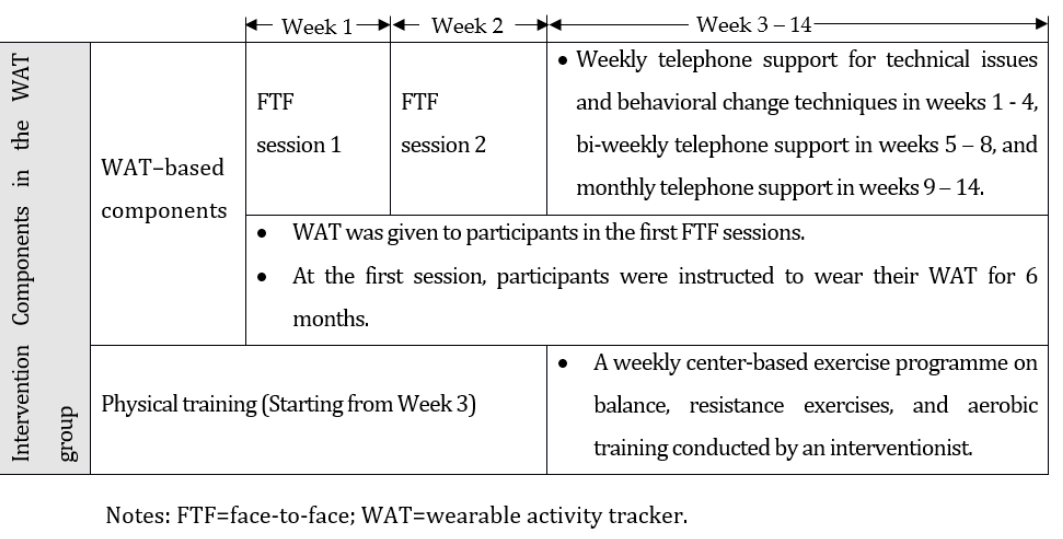
Figure 1. Intervention components for the WAT group.